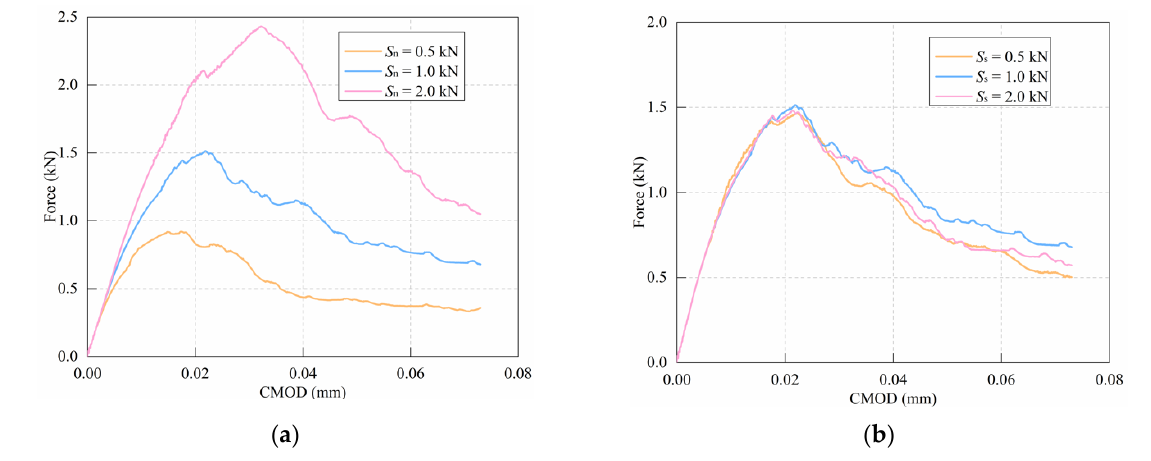
Figure 14. Effect of bond force: ( a ) normal bond force; ( b ) shear bond force.